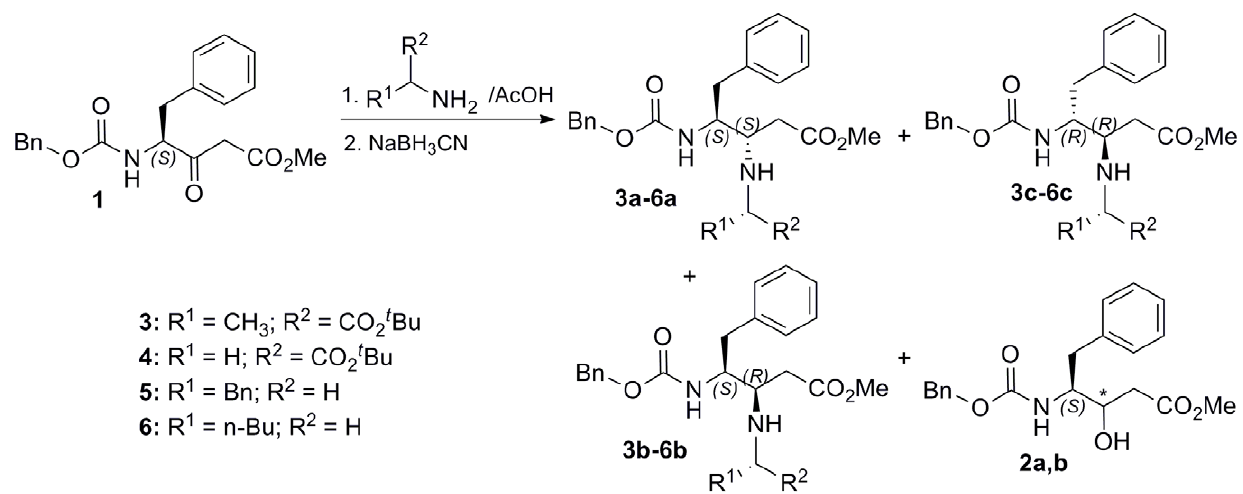
Figure 2. Synthetic procedure for b , c –diamino esters by reductive amination of Phe-derived b –ketoester 1.